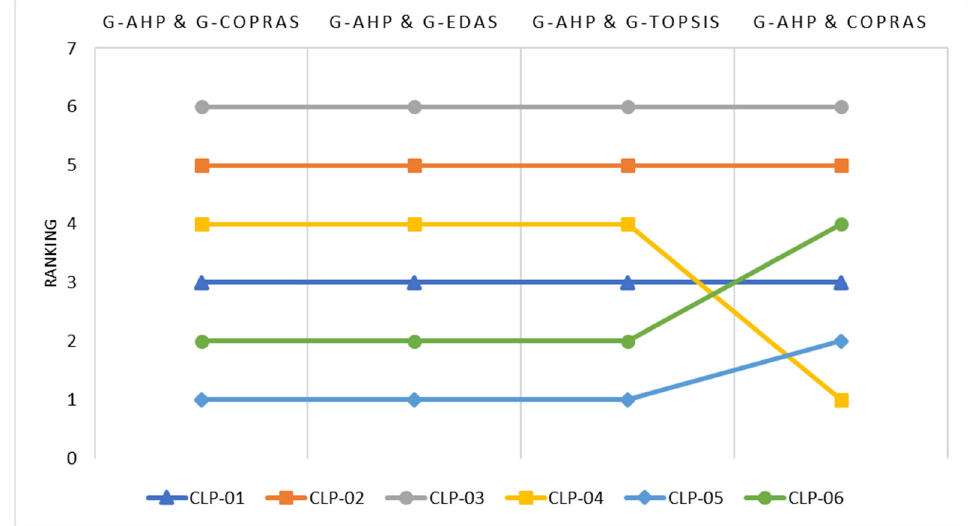
Figure 6. Comparative analysis of methods.